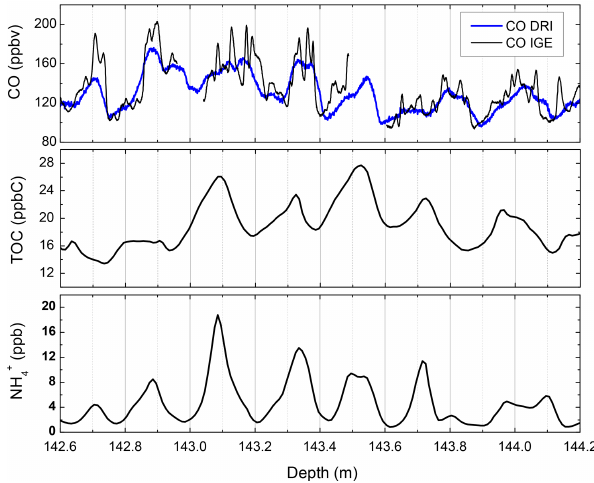
+ , and CO from the PLACE Figure 2. High-resolution TOC, NH 4 core. CO mixing ratios were measured with both the DRI and IGE CFA systems. NH + shows a well-marked seasonal cycle character- 4 ized by a summer maximum. PLACE snow accumulation is about 20cmw . e . yr − 1